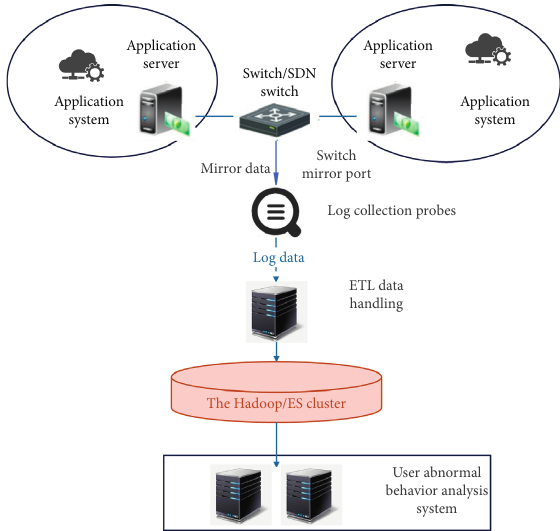
Figure 6: System deployment